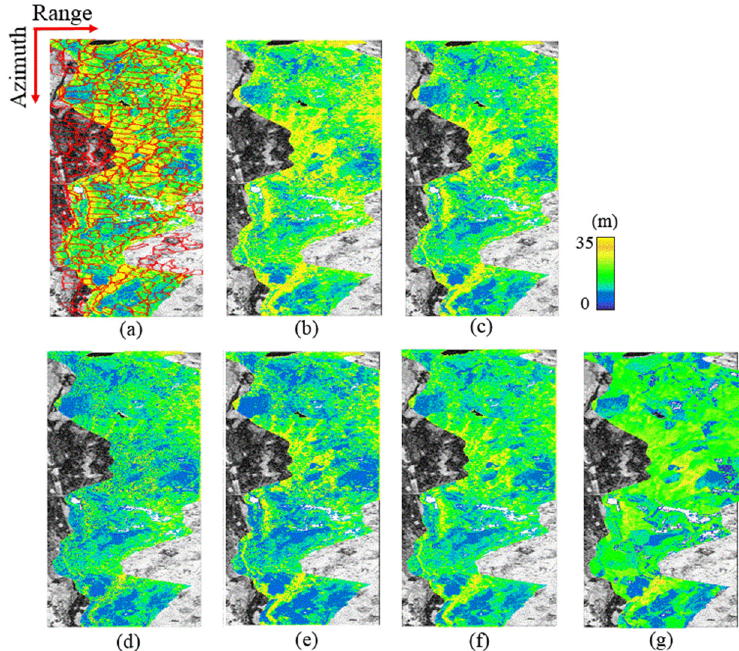
Figure 8. Interferometric coherence of HH polarization scaled from 0 (black) to 1 (white) with the Forest CHM maps superimposed. ( a ) PolInSAR-derived CHM map with 181 cross-validation stands (red polygons). ( b – f ) show the InSAR-derived CHM maps: ( b ) CHM map acquired by the modified three-stage method based on the TF-RVoG model. ( c ) CHM map with a limited extinction coefficient for the residual ground scattering correction. ( d , e ) show the CHM maps based on the RVoG + VTD model: ( d ) CHM map with a fixed extinction coefficient, ( e ) CHM map with a fixed temporal decorrelation factor. ( f ) show the CHM map based the RVoG + MTD model. ( g ) LiDAR-derived CHM map.